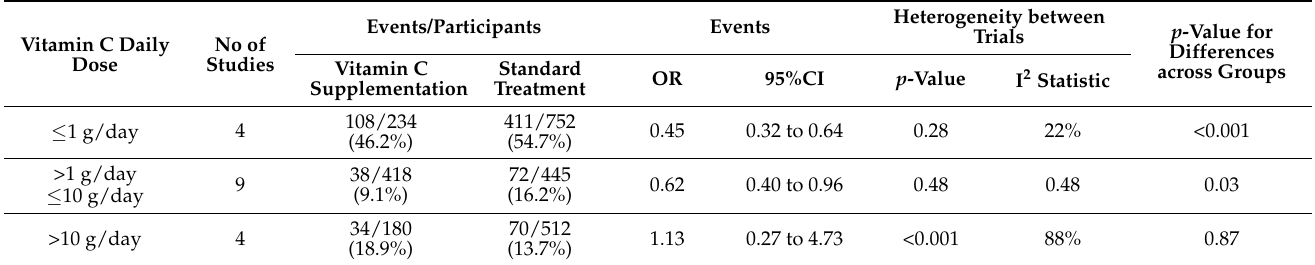
Table 3. The dose of vitamin C and one-month